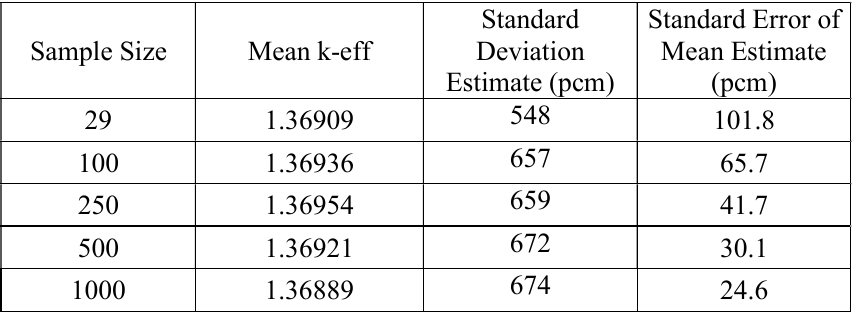
Table V. Error in mean k-eff for PWR colorset at HFP : Effective neutron multiplication factor and uncertainty calculated by MPACT and from